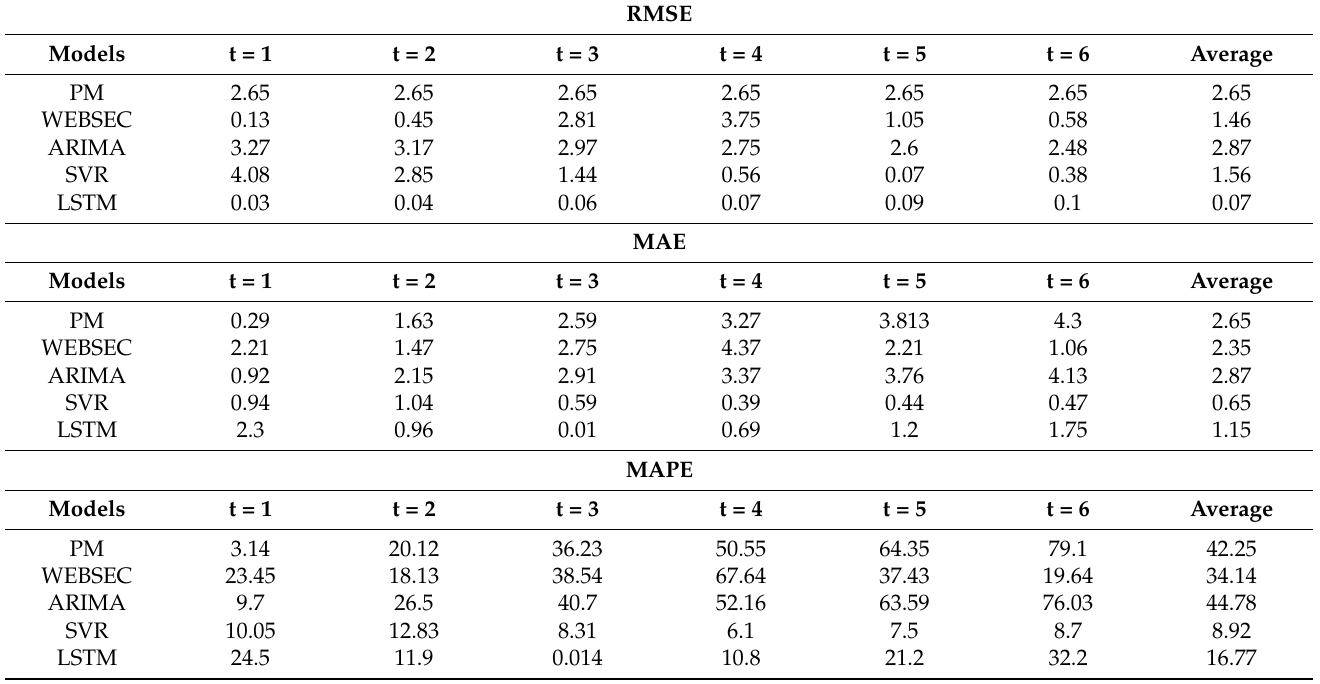
Table 7. Performance results of different univariate WSP models for Southern Offshore TX region.